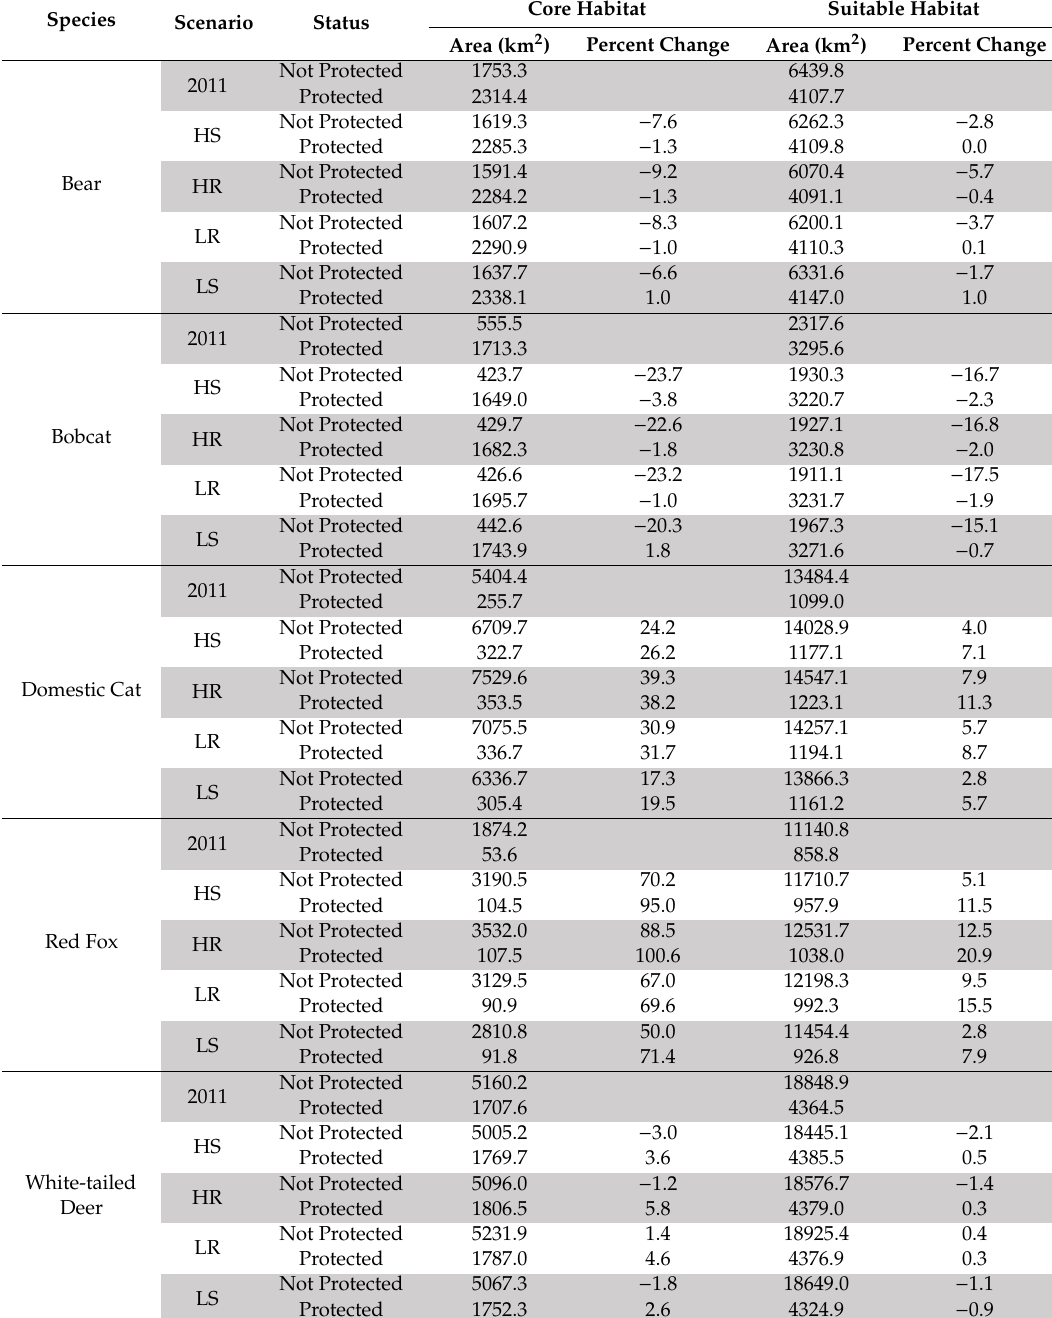
Table 3. Estimated core and suitable habitat area and percent changes over time for five representative mammals in protected and non-protected areas during the contemporary period (2011) and under four land planning scenarios into 2060. HS represents high human population growth and strategic planning, HR represents high human population growth and reactive planning, LR represents low population growth and reactive planning, and LS represents low population growth and strategic planning. Habitat areas were predicted from the top-ranking occupancy models with e ff ects of land cover and anthropogenic covariates from 1591 camera trap locations across an urban to rural gradient, northern Virginia,